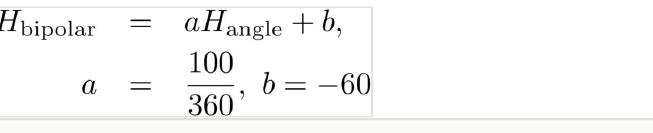
Figure 4. Equation for converting hue values in units degree to hue values as bipolar percent, where blue is near zero.